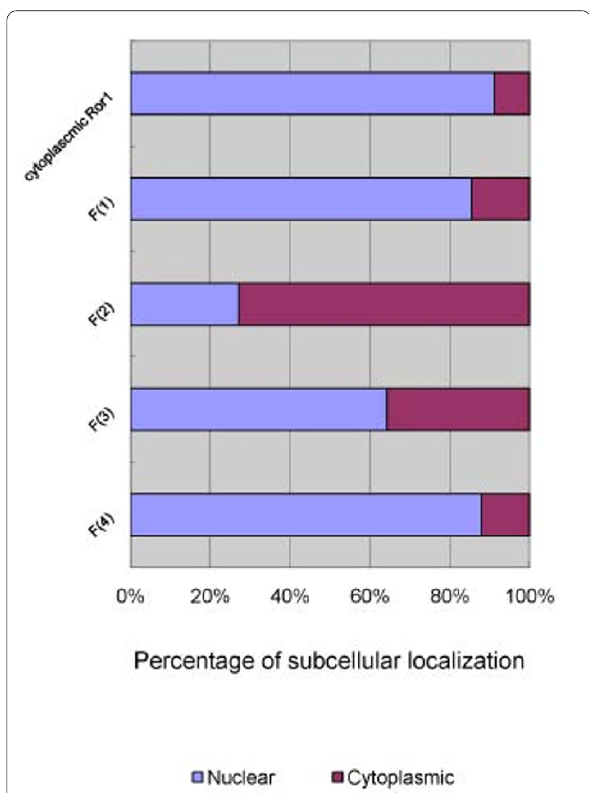
Figure 3 Quantification of the subcellular distribution ratios of different Ror1 fragments . The mean percentage of FITC fluorescence in the nuclear or cytoplasmic compartments for each construct was determined by analyzing the FITC intensity from 30 randomly selected